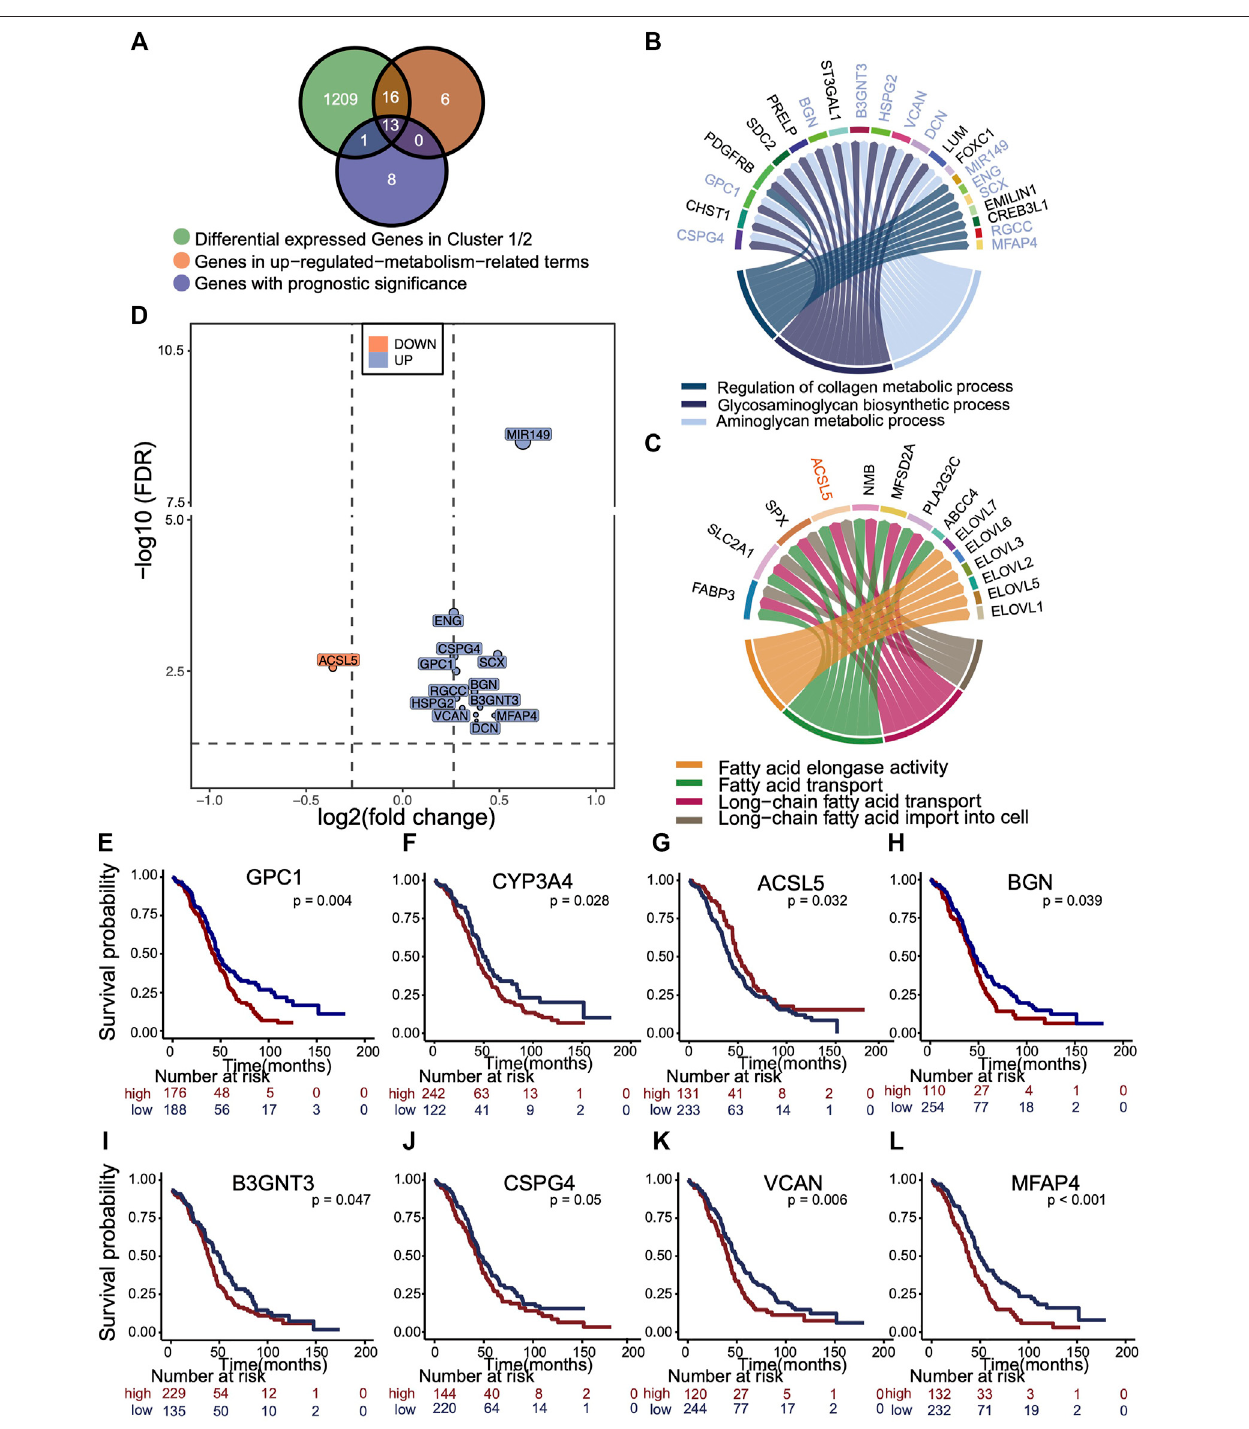
FIGURE5| Selectionofrepresentativegenesdifferentiallyexpressedinm 5 Ccluster,relatedtometabolismandwithprognosticsigni fi cance. (A) Vennplotshowing theoverlappinganalysisofgenesthatweredifferentially expressed (foldchange > 1.5and p < 0.05)intwoclusters,enriched inup-regulatedmetabolicpathwaysineach cluster, and had the prognostic signi fi cance. (B,C) Circus plot exhibiting the metabolic pathways up-regulated in each m 5 C cluster and those 13 genes with prognostic valueweremarked. Blue, up-regulatedin cluster 1. Orange, up-regulated in cluster 2. (D) Volcano plot distributesthe relative expressions13 representative genes with log2 (fold change) and log10 (FDR). The reference is gene expression of cluster 1. Blue, up-regulated in cluster 1. Orange, up-regulated in cluster 2. (E – L) Kaplan – Meier overall survival curves of eight representative genes.